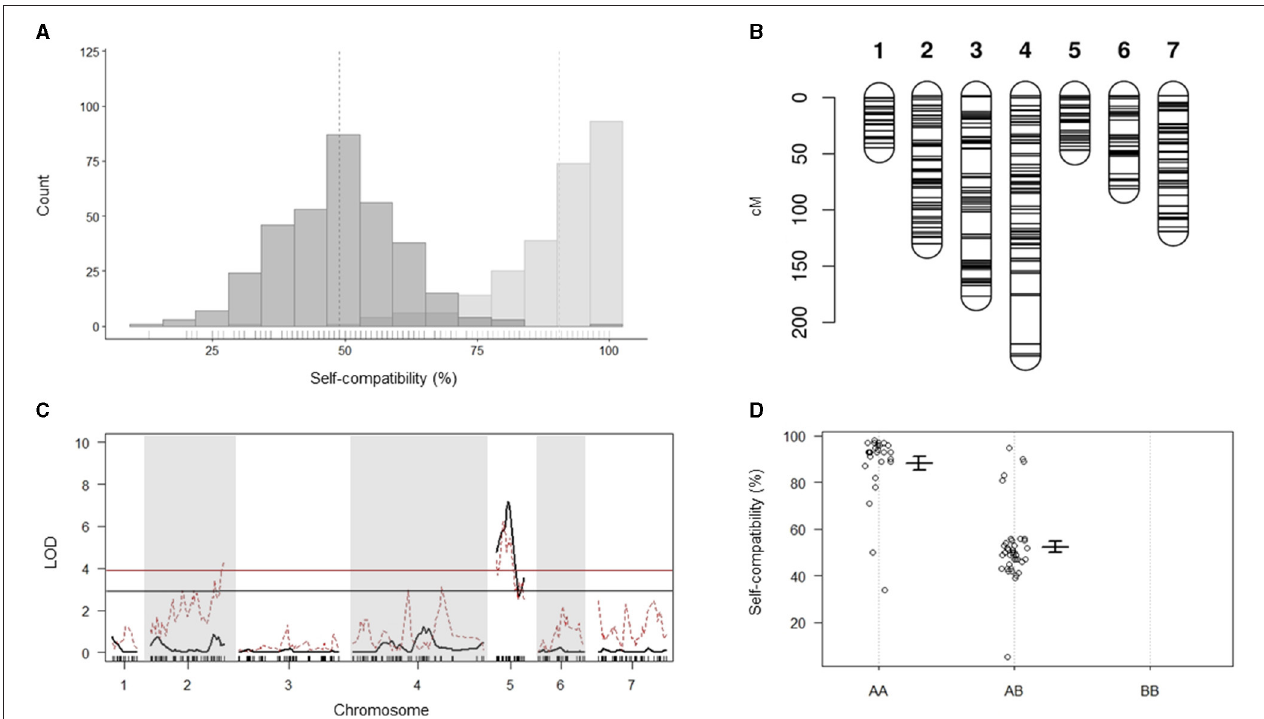
FIGURE 2 | Quantitative trait locus (QTL) analysis for self-compatibility (SC). (A) The bi-modal phenotypic segregation for the SC phenotype of the 74 individuals was used for the generation of the linkage map, QTL analysis, and segregation distortion analysis. Data distributions and means (indicated by the vertical dotted lines) displayed in dark gray for individuals with a 50% SC phenotype and light gray for the 100% self-compatible individuals. Small solid vertical lines above the horizontal axis indicate single data points. (B) Genetic linkage map displaying the distribution of the 473 markers across the seven linkage groups of perennial ryegrass used for the QTL analysis. (C) QTL analysis for SC (black line) and analysis of segregation distortion (red dotted line). Significance thresholds are indicated by the black and red horizontal lines for the QTL analysis and segregation distortion analysis, respectively. (D) Marker effect plot for the most significant marker. AA represents the homozygous genotype for the SC phenotype, while AB and BB represent the heterozygous and homozygous genotypes for the self-incompatible phenotype, respectively. Plots show the mean and SD for the SC